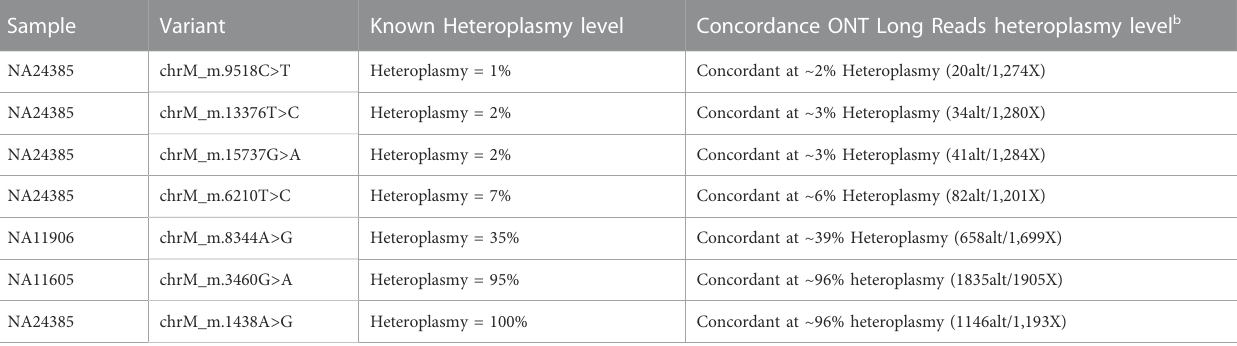
TABLE 3 Clinical validation of Small Sequence Changes a (SSC) up to 50bp with various level of Mitochondrial Heteroplasmy detection with long read sequencing. Sample